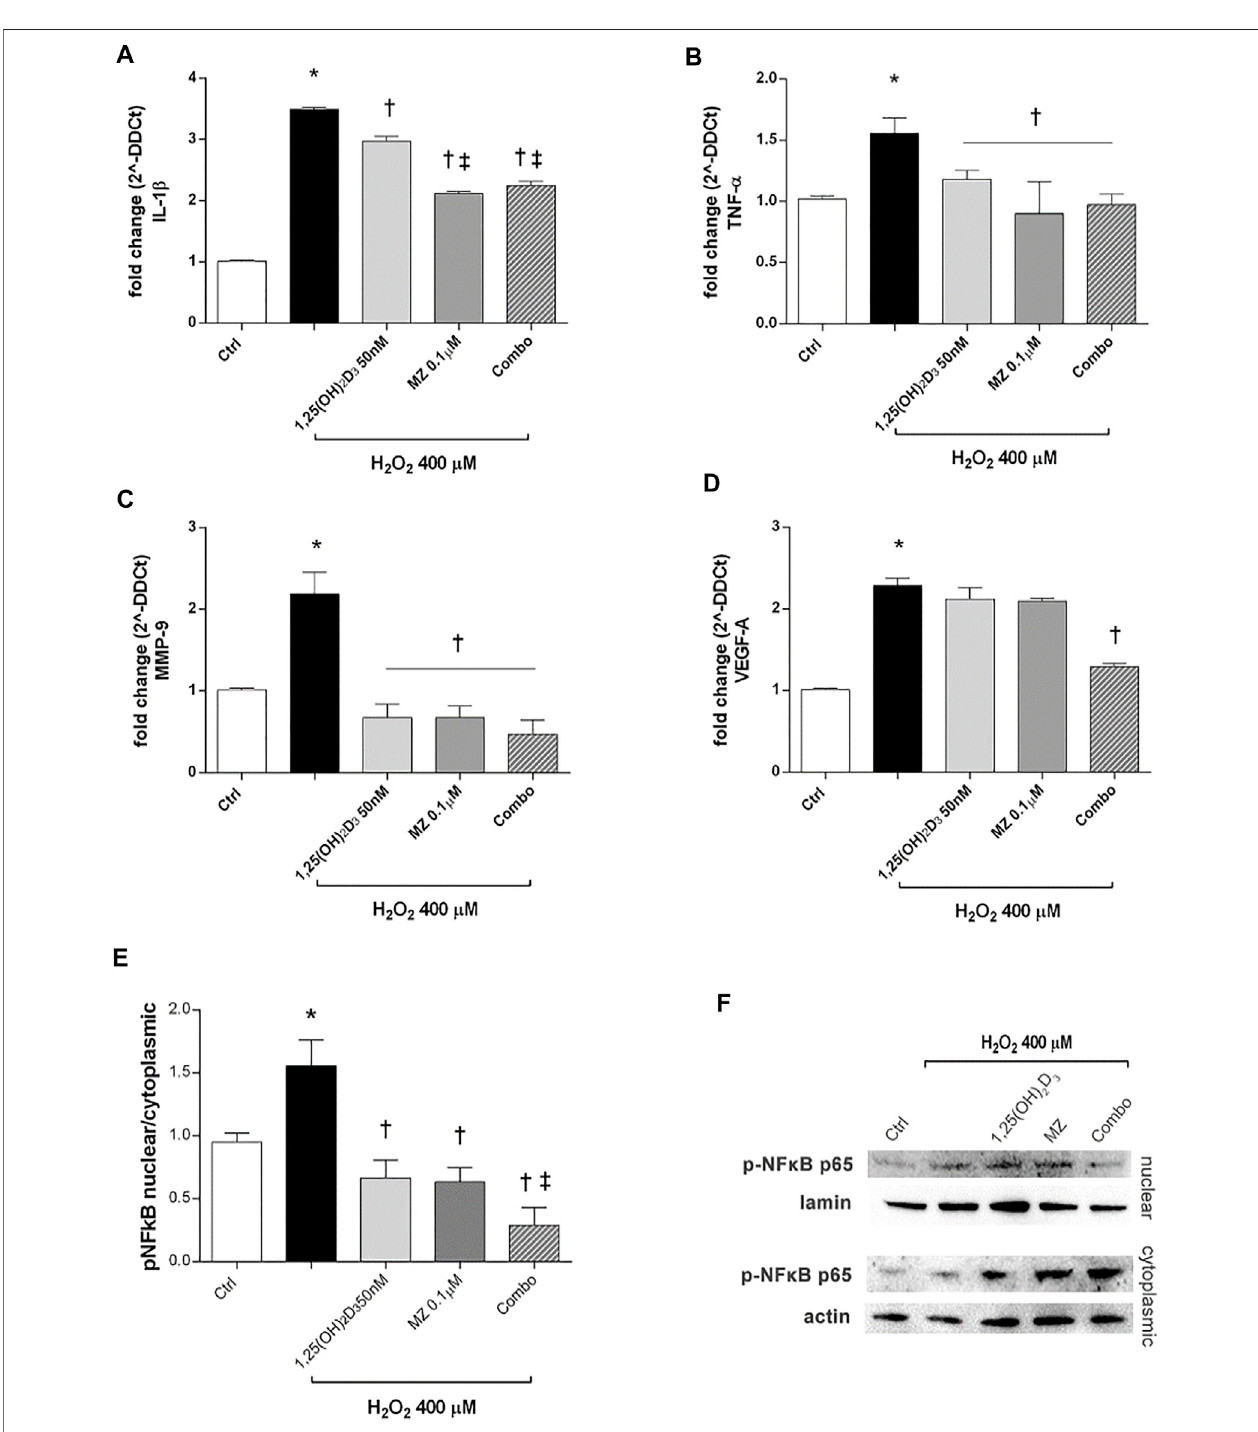
FIGURE 4 | 1,25(OH) 2 D 3 , MZ, and their combination attenuate H 2 O 2 -induced in fl ammation. 1,25(OH) 2 D 3 , MZ, and the combination reduced IL-1 β (A) , TNF- α (B) , and MMP-9 (C) mRNA expression. The combo decreased VEGF-A mRNA expression induced after 6 h of H 2 O 2 treatment (D) . ARPE-19 cells were pretreated for 24 h with 1,25(OH) 2 D 3 (50 nM), MZ (0.1 µM), and their combo (1,25(OH) 2 D 3 50 nM + meso-zeaxanthin 0.1 µM), and then challenged with H 2 O 2 (400 µM) for 6 h. The mRNA levelswereevaluatedbyqPCR. (E) Westernblotanalysis.Densitometryanalysisofeachband(ratioofnuclear p -NF κ Bp-65/laminBandcytoplasmic p -NF κ Bp-65/ actin) was carried out with ImageJ program. (F) Representative blots of nuclear and cytoplasmic proteins. Each bar represents mean value ± SD (n (cid:2) 5; each run in triplicate). Data were analyzed by one-way ANOVA and Tukey ’ s post hoc test for multiple comparisons. * p < 0.05 vs. control; † p < 0.05 vs. H 2 O 2 ; ‡ p < 0.05 vs. 1,25(OH) 2 D 3 and